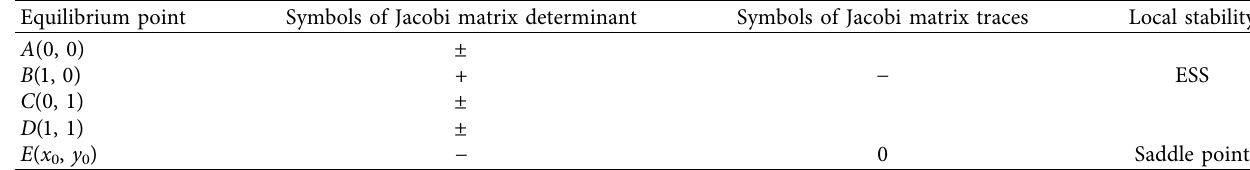
Table 7: Local stability analysis of equilibrium points.